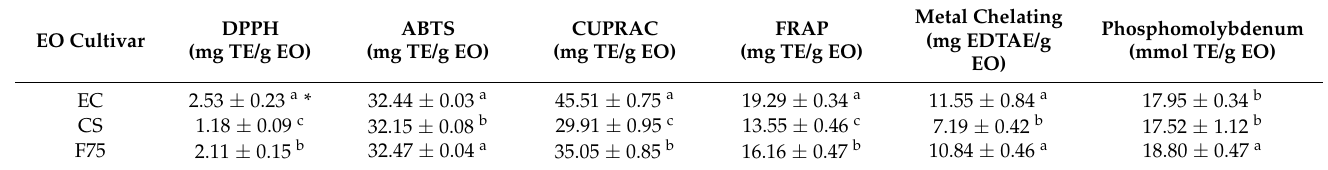
Table 3. Scavenging/reducing and metal-chelating properties of the tested hemp essential oils.